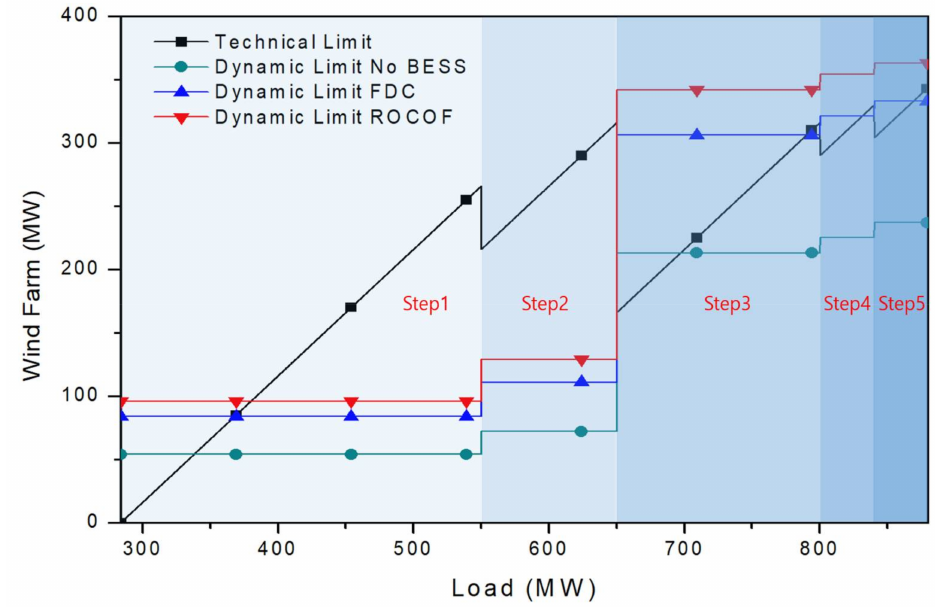
Figure 14. The dynamic limit capacity of wind farms with the technical limit capacity in Jeju